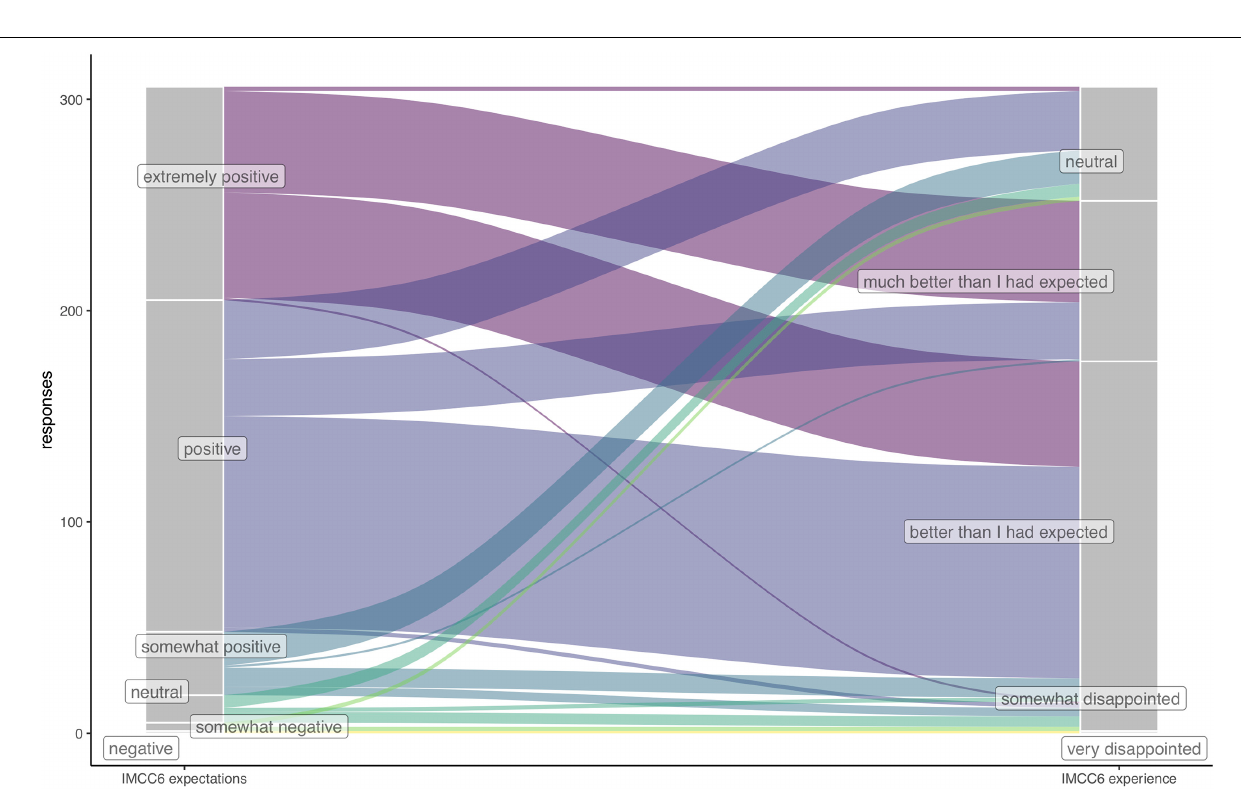
FIGURE 4 | Comparison of survey respondents’ expectations for IMCC6 and respondents’ IMCC6